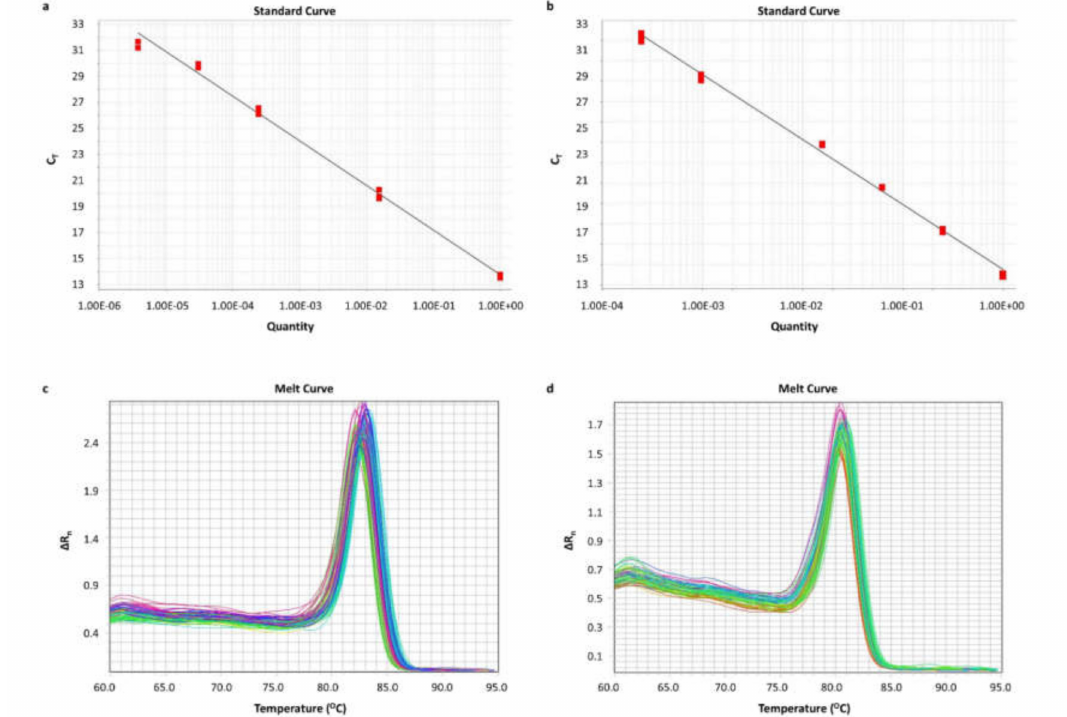
Figure 2. Standard curves built by plotting the threshold cycle (C T ) versus the dilution, and melt curves observed. For the standard curves, PCR products generated from pre-amplification of Caco-2 cDNA were used. ( a ) Standard curve for circ-BCL2L12-1; 8-fold serial dilutions of the Caco-2 PCR product were used. ( b ) Standard curve for circ-BCL2L12-2; 4-fold serial dilutions of the Caco-2 PCR product were used. ( c ) Melt curve of circ-BCL2L12-1; ( d ) Melt curve of